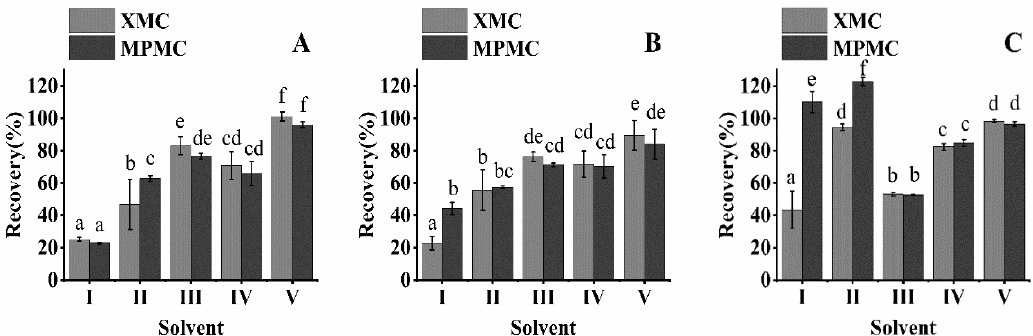
Figure 2. Effect of different solvents on dimethacarb extraction in three matrix samples (spike at 0.1 mg/kg): ( A ) rice straw, ( B ) rice husk, and ( C ) brown rice. ( Ⅰ ) ethyl acetate, ( Ⅱ ) dichloromethane, (Ⅲ ) methanol, ( Ⅳ ) acetonitrile, ( Ⅴ ) 1% acetic acid acetonitrile. (abcdef: different letters represent statistically significant differences between the extraction effects of different extractants on XMC and MPMC, p < 0.05).